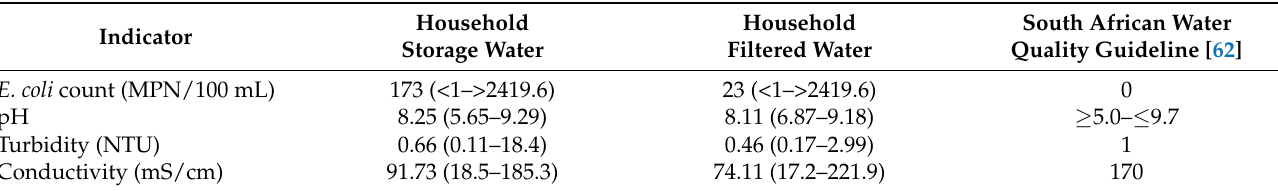
Table 1. Average counts for indicators of water